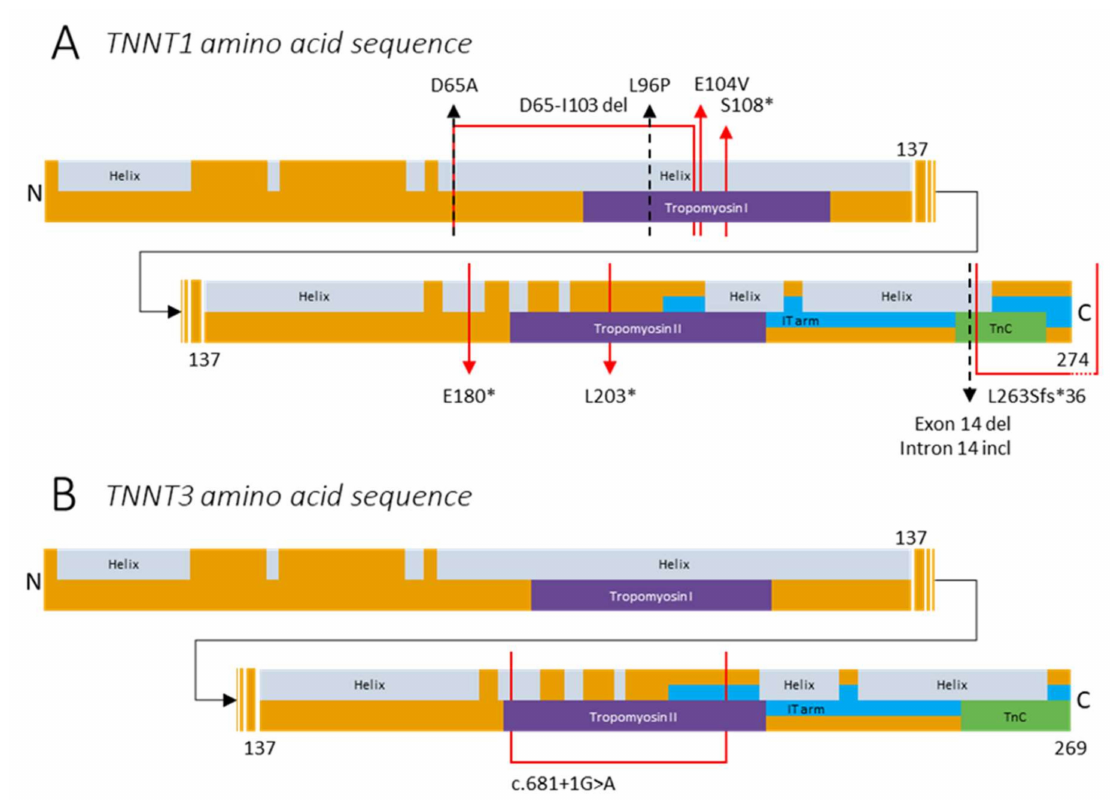
Figure 4. Protein structure and reported variants in ( A ) TNNT1 (UniProt (P13805, TNNT1_Human)) and ( B ) TNNT3 (UniProt (P45378,